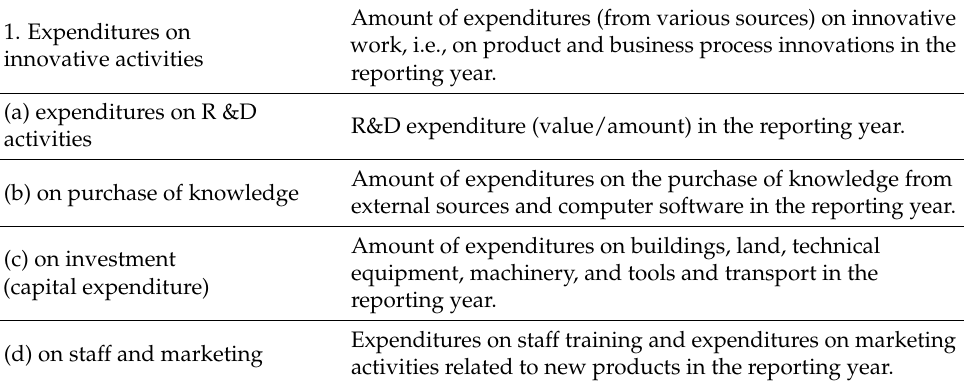
Table 2. Typology of expenditures on product and business process innovations in the Polish industrial statistical report.